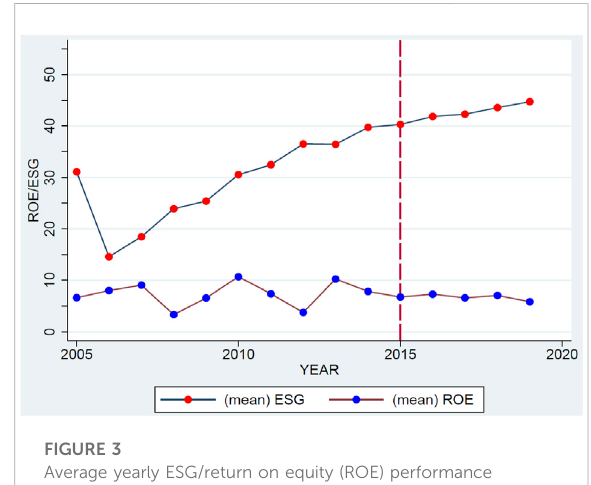
FIGURE 3 Average yearly ESG/return on equity (ROE) performance scores.